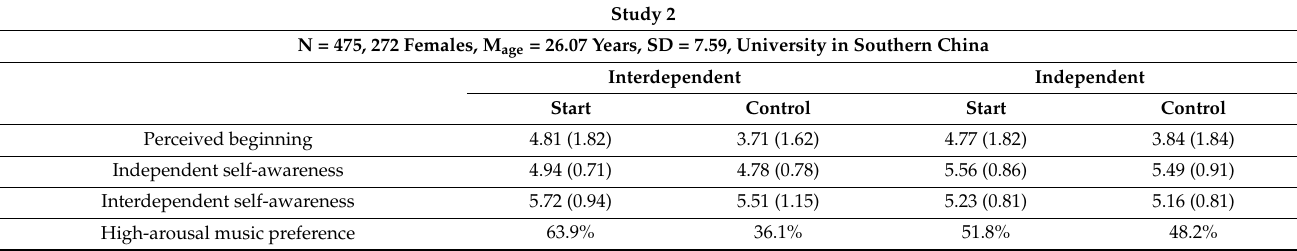
Table 5. Statistics descriptive results in Study 2.